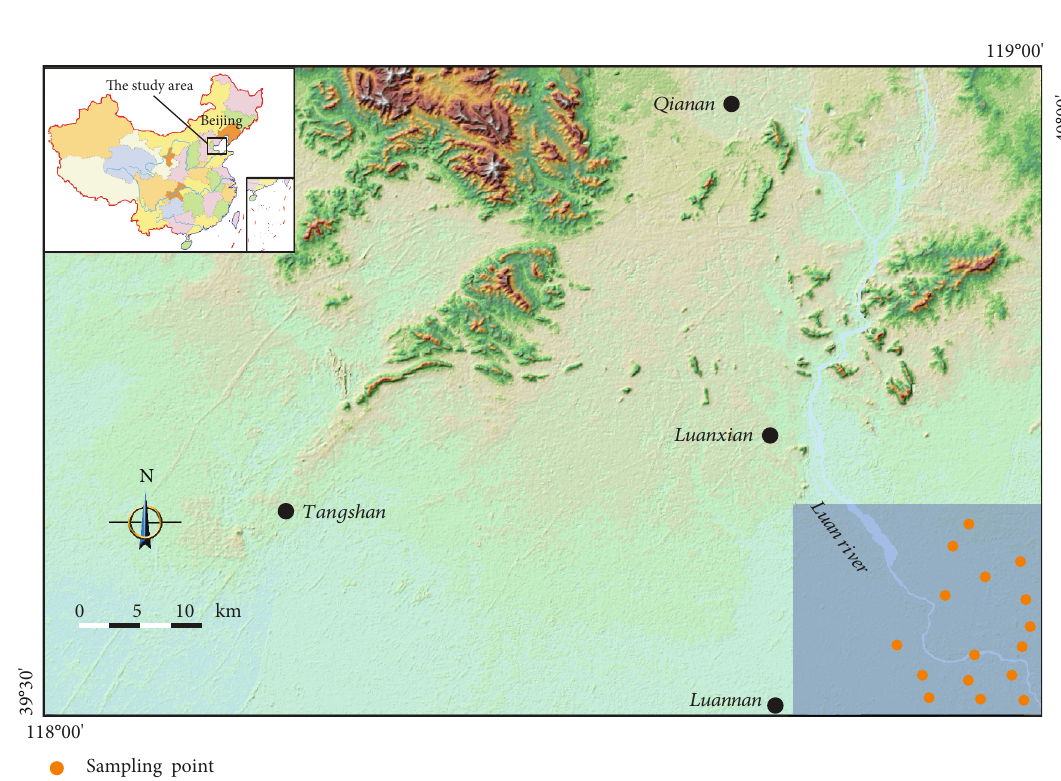
Figure 1: Location of study area and groundwater